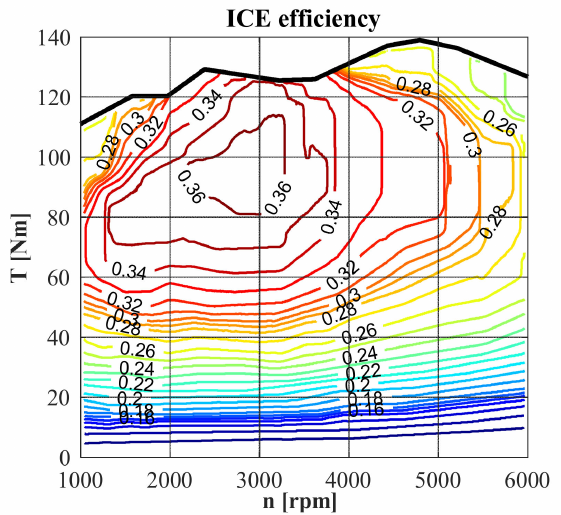
Figure 4. Efficiency map of the Chevrolet Volt ICE derived from [37].